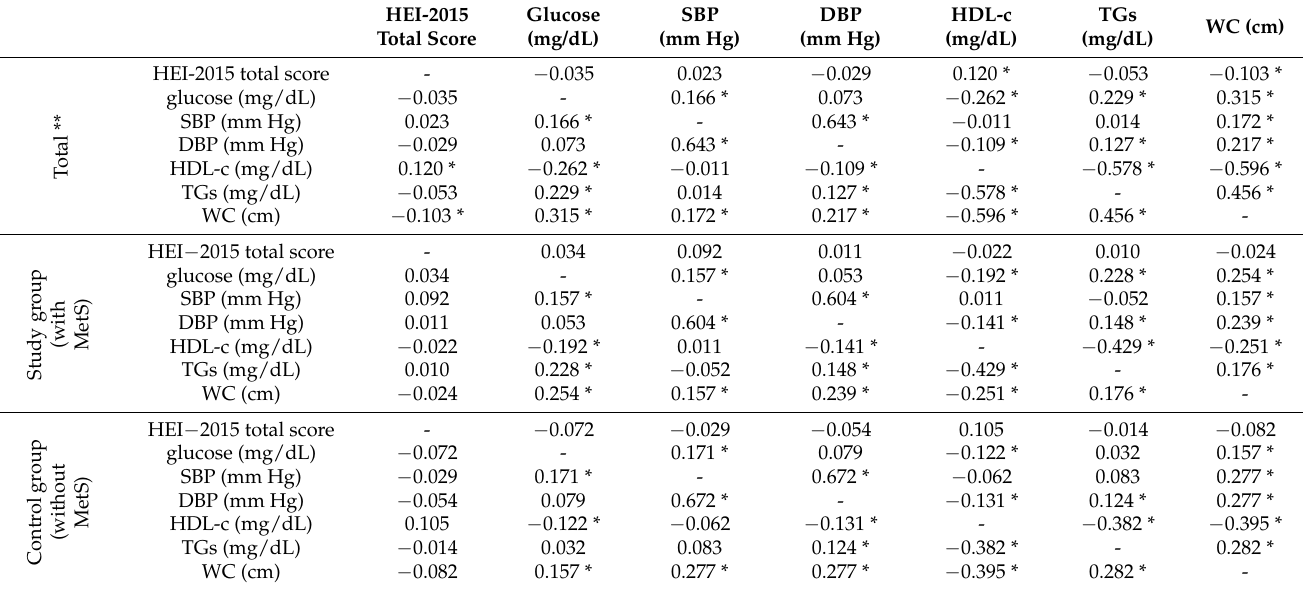
Table 5. Spearman's correlations between HEI-2015 total score and metabolic syndrome